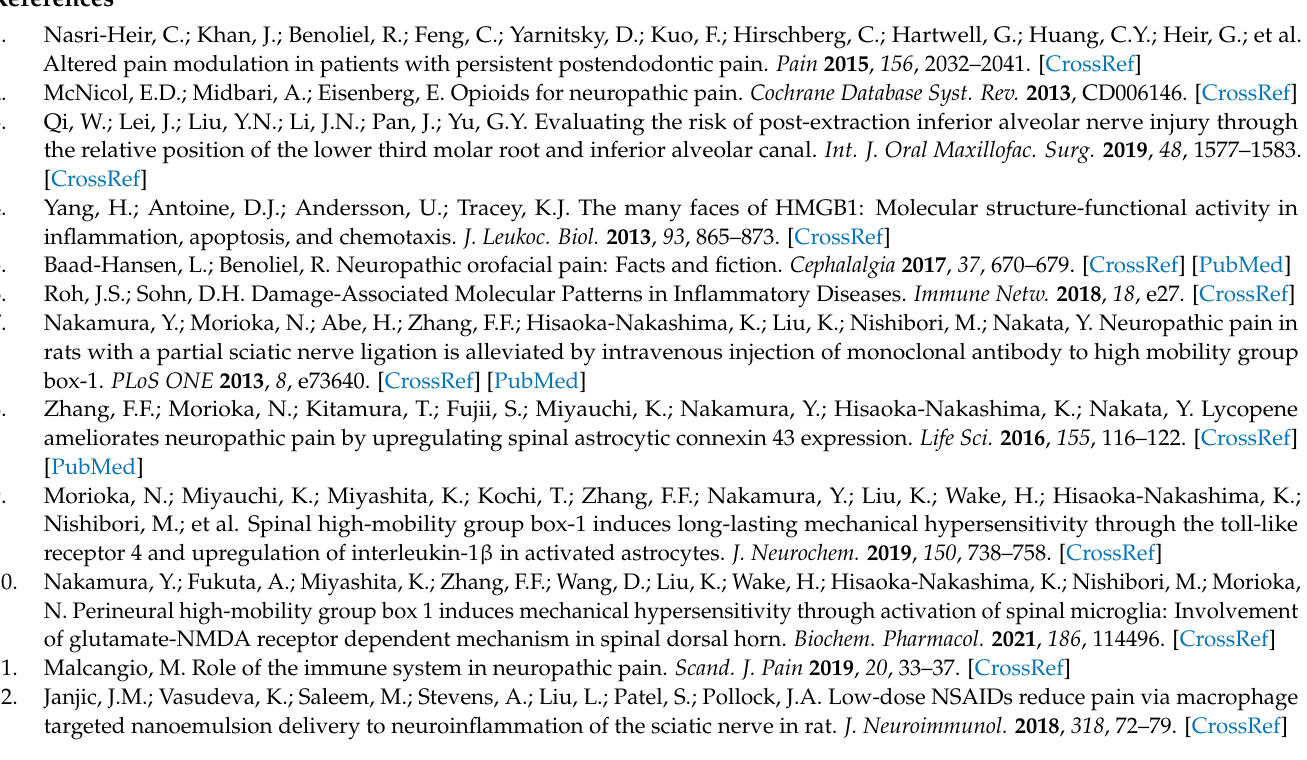
Supplementary Materials: Figure S1: Effect of anti-HMGB1 nAb treatment after dIoN-CCI, Figure